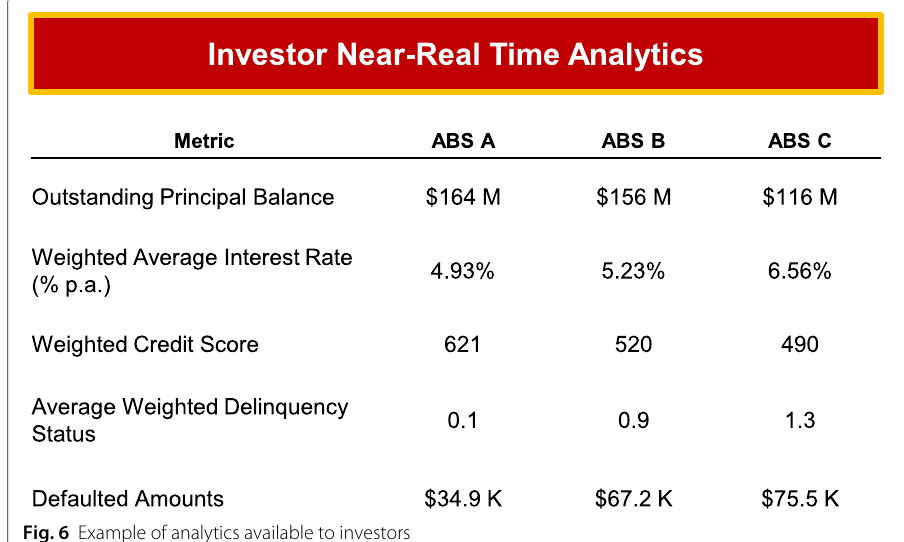
Fig. 6 Example of analytics available to